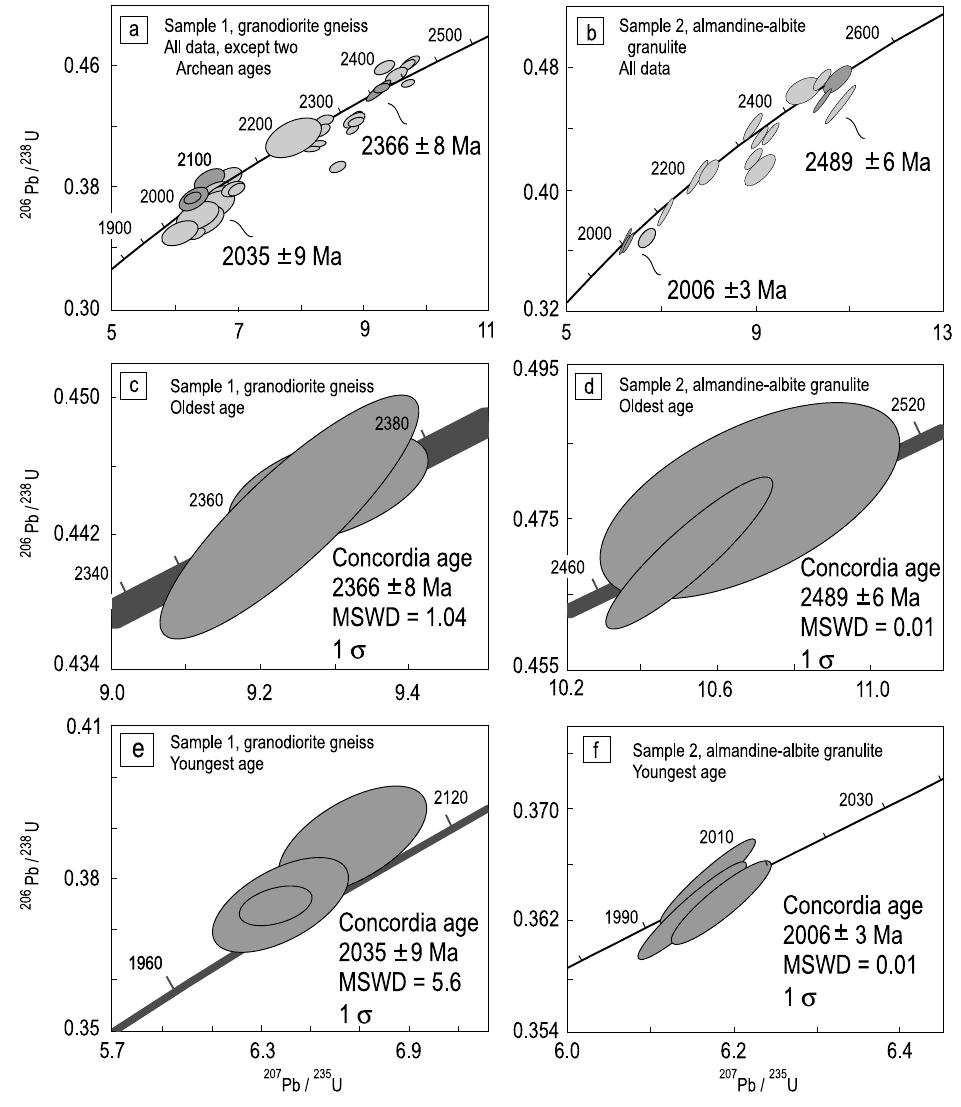
Fig. 3 – Concordia diagrams of dated samples 1, granodiorite gneiss (a, c and e) and sample 2, felsic almandine-albite granulite (b, d and f). Oldest and youngest concordia ages of each sample